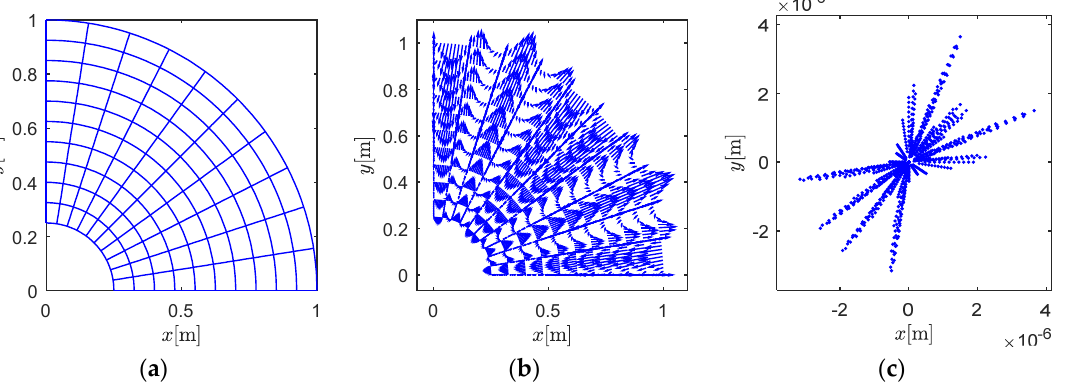
Figure 1. B-spline wavelets on the interval (BSWI)4 3 interpolation for a quarter circle: ( a ) BSWI interpolation, ( b ) the quiver figure for error, ( c ) the value of error.